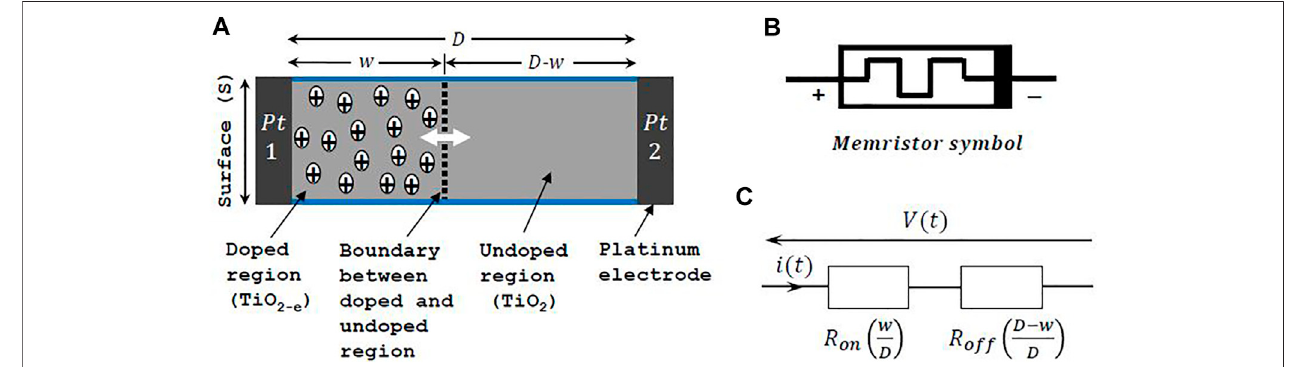
FIGURE2| Structure oftheTiO 2 memristor. Thedopedregion TiO 2-e and theundoped region TiO 2 are, respectively, thehigher and lowerconducting regions with resistance R on ( w / D ) and R off ( D − w / D ) . (A) Memristor schematic, (B) symbol, and (C) internal behavioral response.